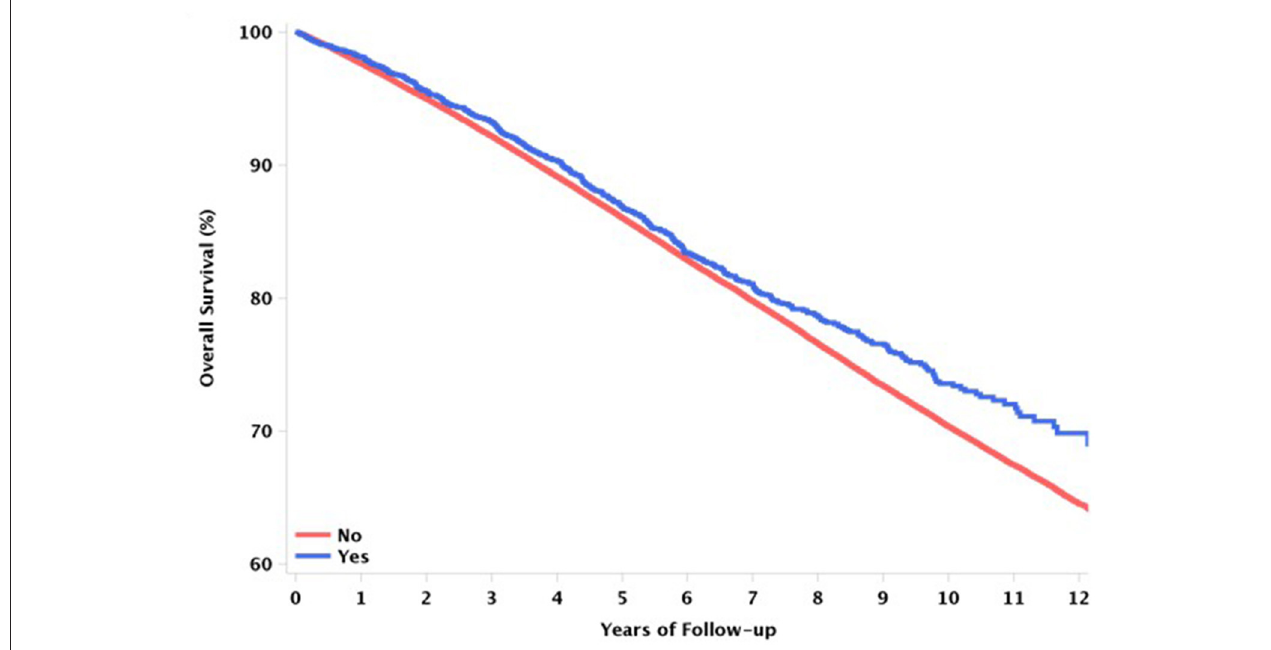
FIGURE 2 | Kaplan–Meier graphs to describe all-cause mortality between the vitrectomy and non-vitrectomy